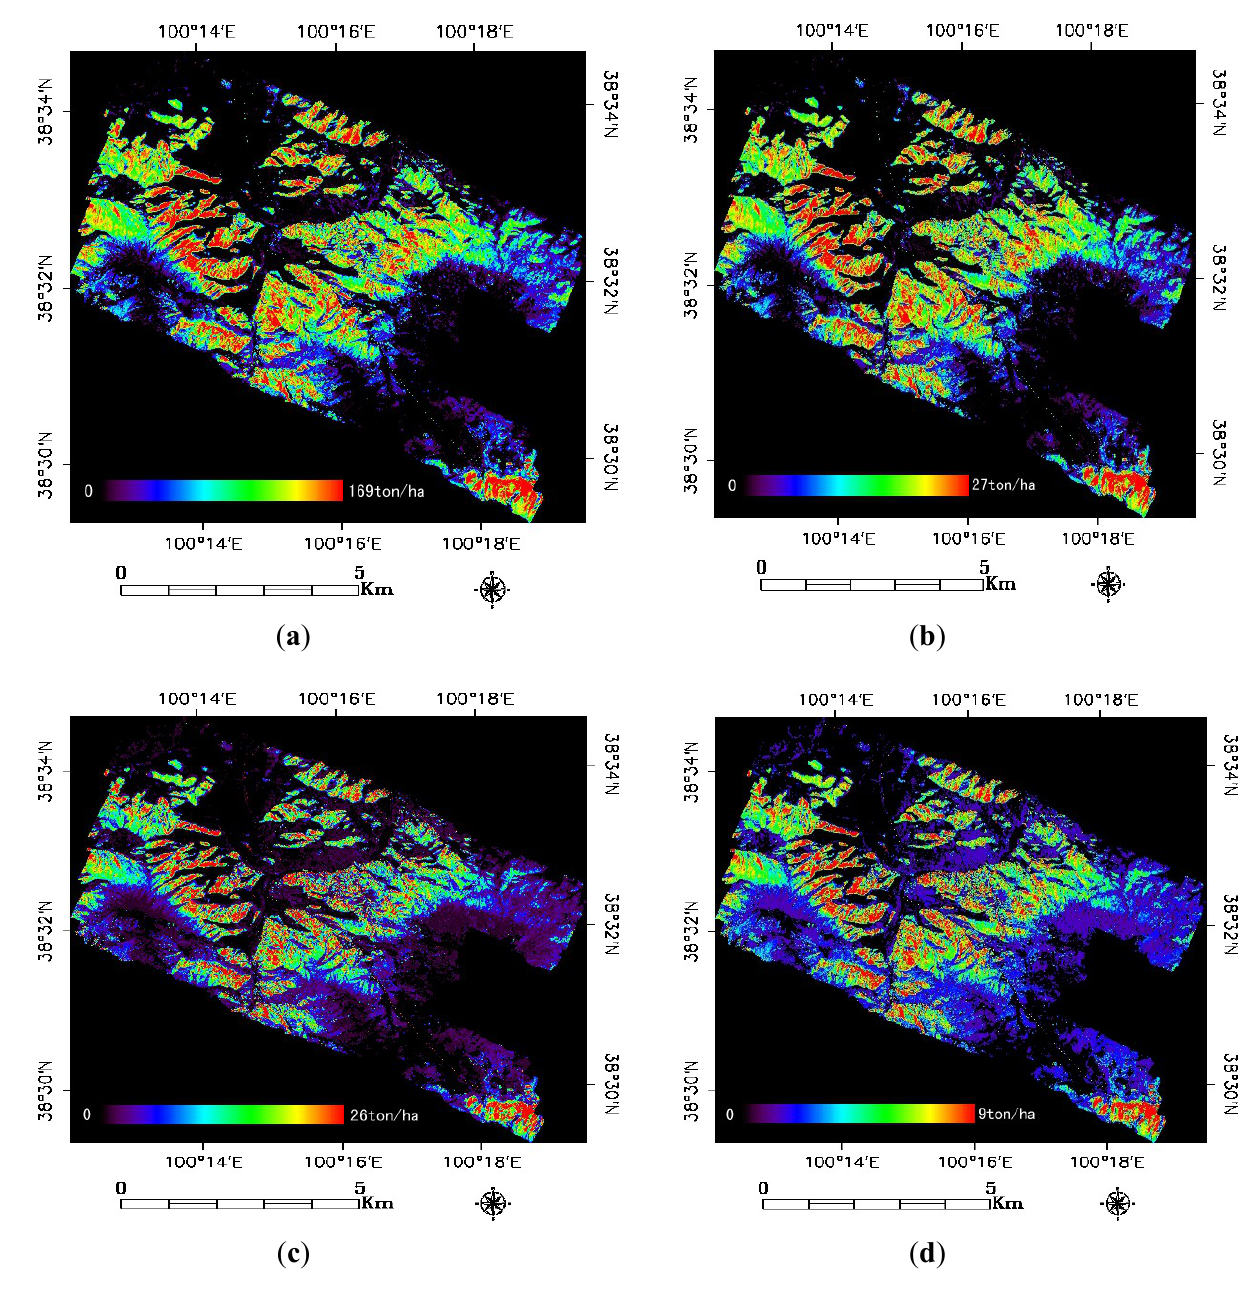
Figure 4. Spatial distributions of above-ground biomass and biomass components. ( a ) Stem biomass; ( b ) Branch biomass; ( c ) Foliage biomass; ( d ) Fruit biomass; ( e ) Crown biomass; and ( f ) Above-ground